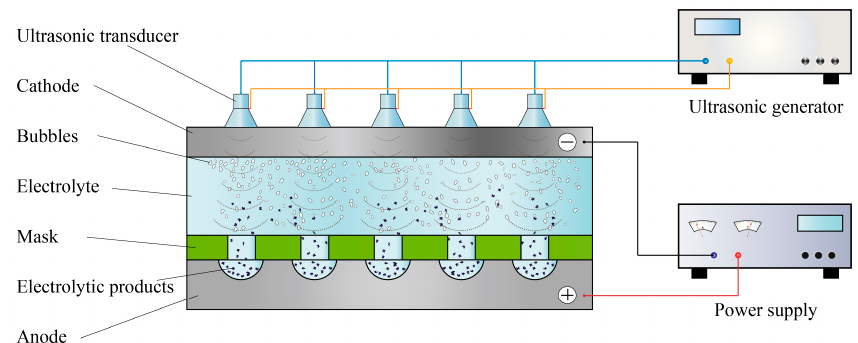
Figure 1. Working principle of ultrasound-assisted through-mask electrochemical machining (TMECM).